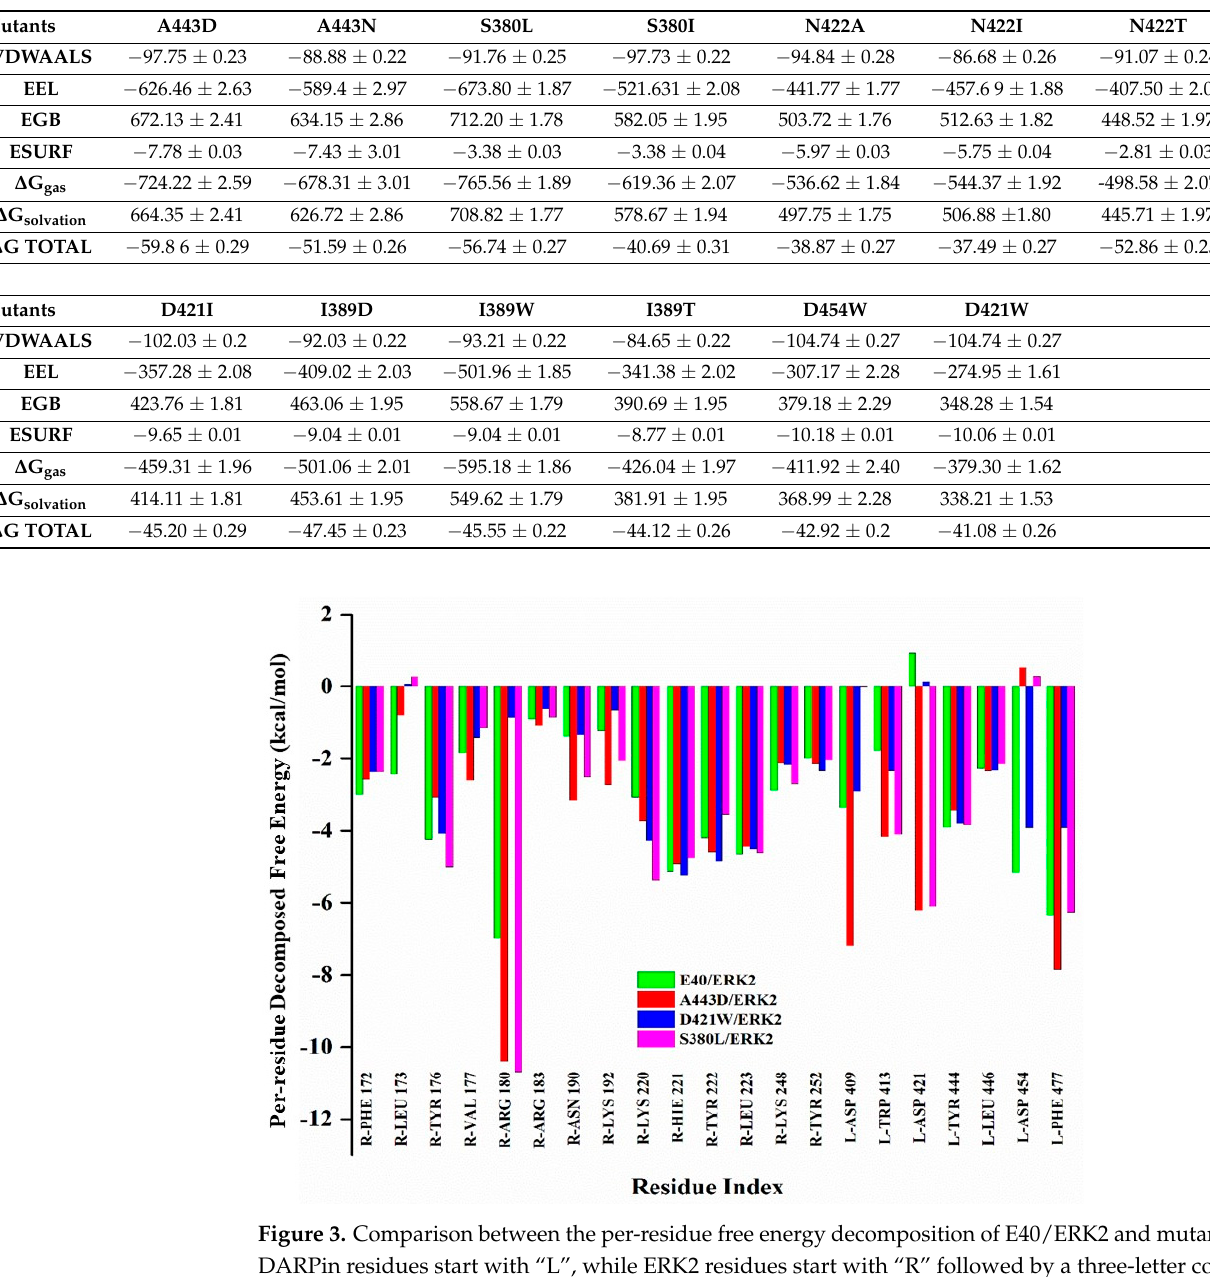
Table 3. Comparison of the energetics in kcal/mol ( ± SEM) of mutants with E40/ERK2 obtained by the MM-PBSA/GBSA method. VDWAALS, van der Waals energy; EEL, MM electrostatic energy. The polar and non-polar contributions are EGB (or EPB) and ESURF (or ENPOLAR), respectively, for MM-GBSA (or MM-PBSA).